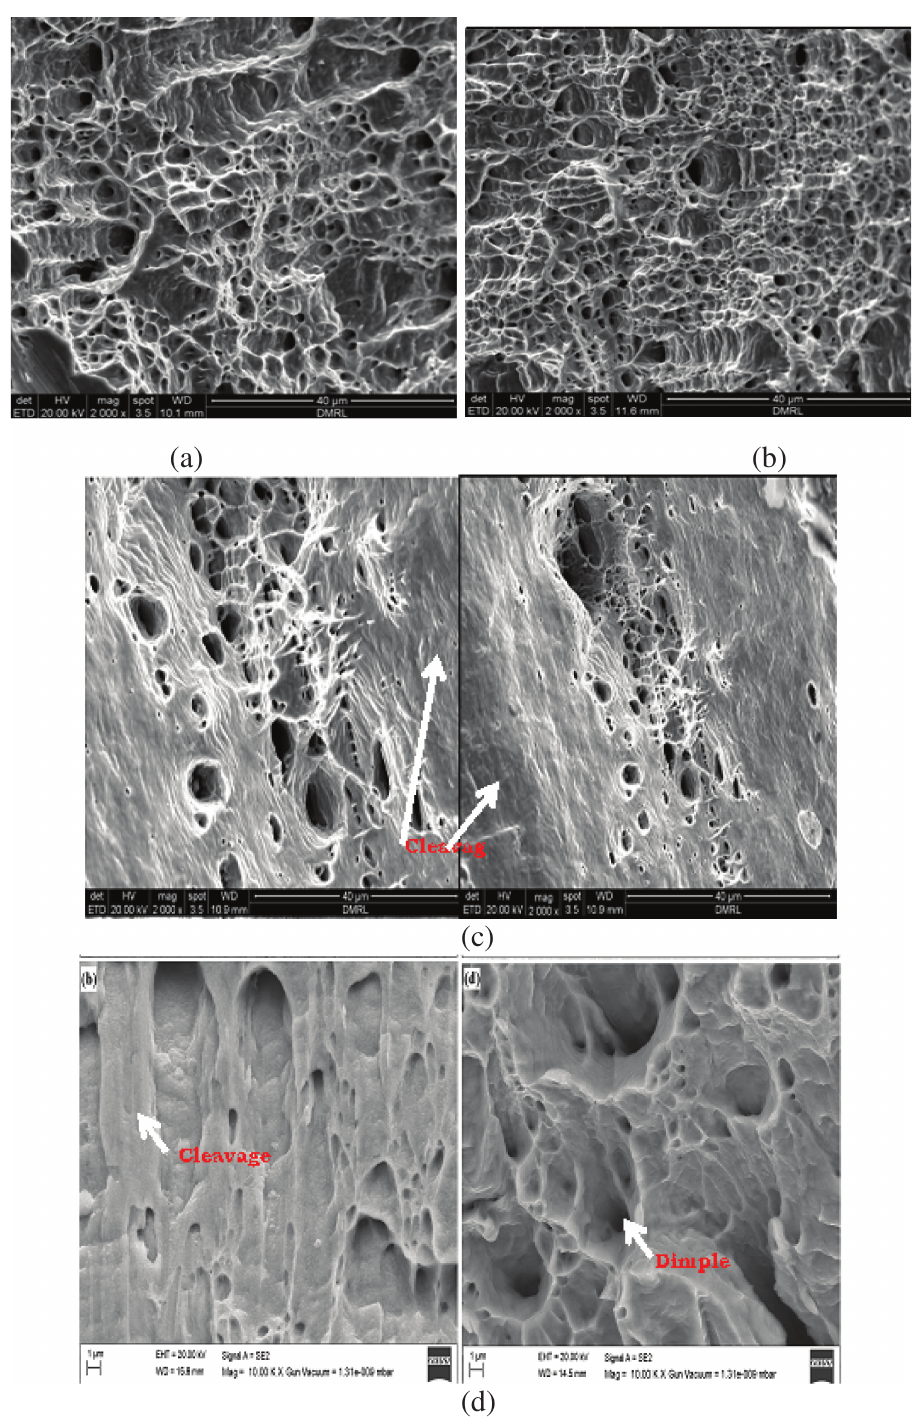
Figure 14: SEM micrographs of fractured tensile specimens for ASS 316 at various temperatures (a) 150°C (b) 300°C (C) 450°C (d)